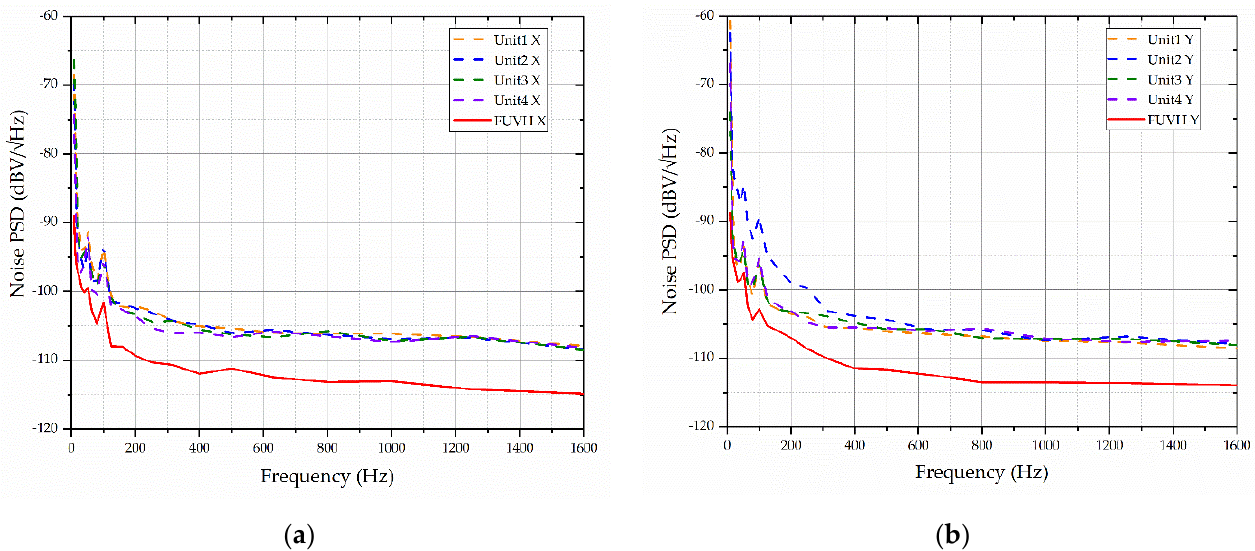
Figure 15. The results of the self-noise test: ( a ) the noise PSD of the X channel and ( b ) the noise PSD of the Y channel.